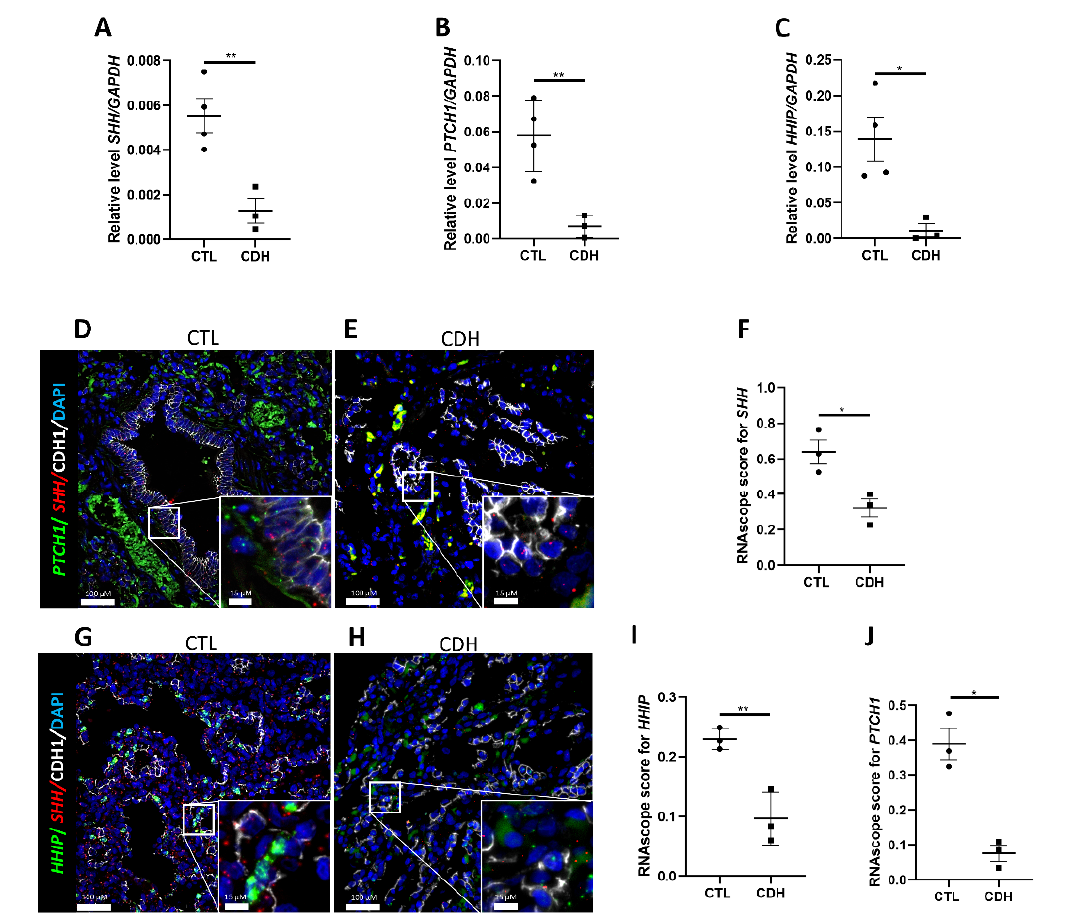
Figure 6. Hedgehog pathway is downregulated in Congenital Diaphragmatic Hernia; ( A – C ) RT-qPCR on tissue from patients presenting with Congenital Diaphragmatic Hernia (CDH) and controls for SHH ( A ), PTCH1 ( B ), and HHIP ( C ) (results show mean ± SEM, * p < 0.05; ** p < 0.01; n = 4 for CTL and n = 3 for CDH). Combinatorial FISH with IF for either PTCH1 (green, ( D , E )) or HHIP (green, ( G , H )) with SHH (red) and CDH1 (IF-white) performed on tissue sections from CDH ( E , H ) and control ( D , G ) patients; dot plot quantification ( F , I , J ) of the FISH signal in CDH vs. control sections (results show mean ± SEM, * p < 0.05; ** p < 0.01; n = 3 for CTL and n = 3 for CDH).